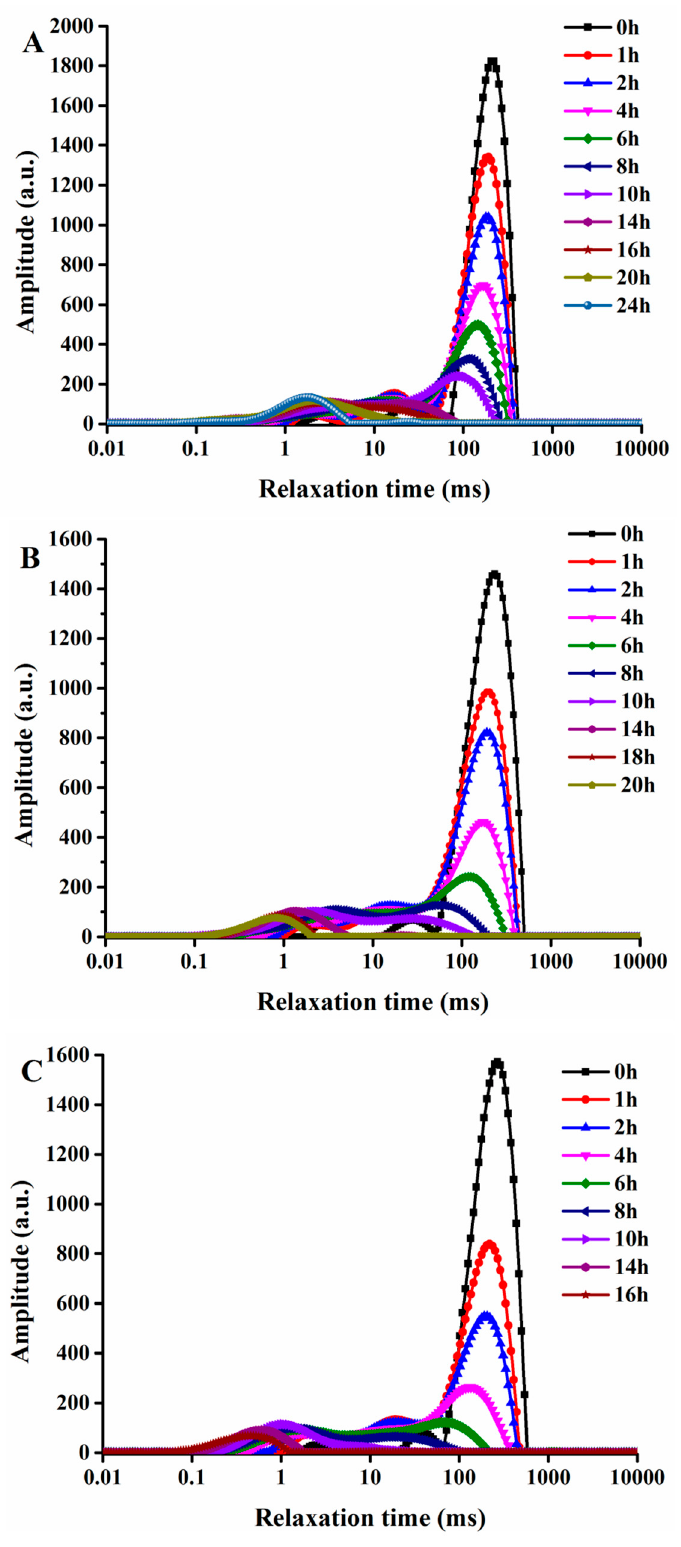
Figure 3. Transverse relaxation time curves of G. elata after steaming at different drying temperatures of ( A ) 40 °C, ( B ) 60 °C, and ( C ) 80 °C.